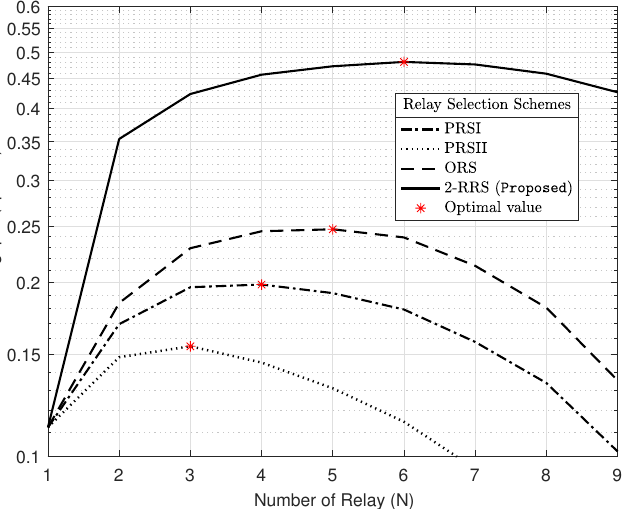
Figure 8. The impact of number of relays on the system throughput performance with different relay selection schemes with P PB = 20dB and M = 16.